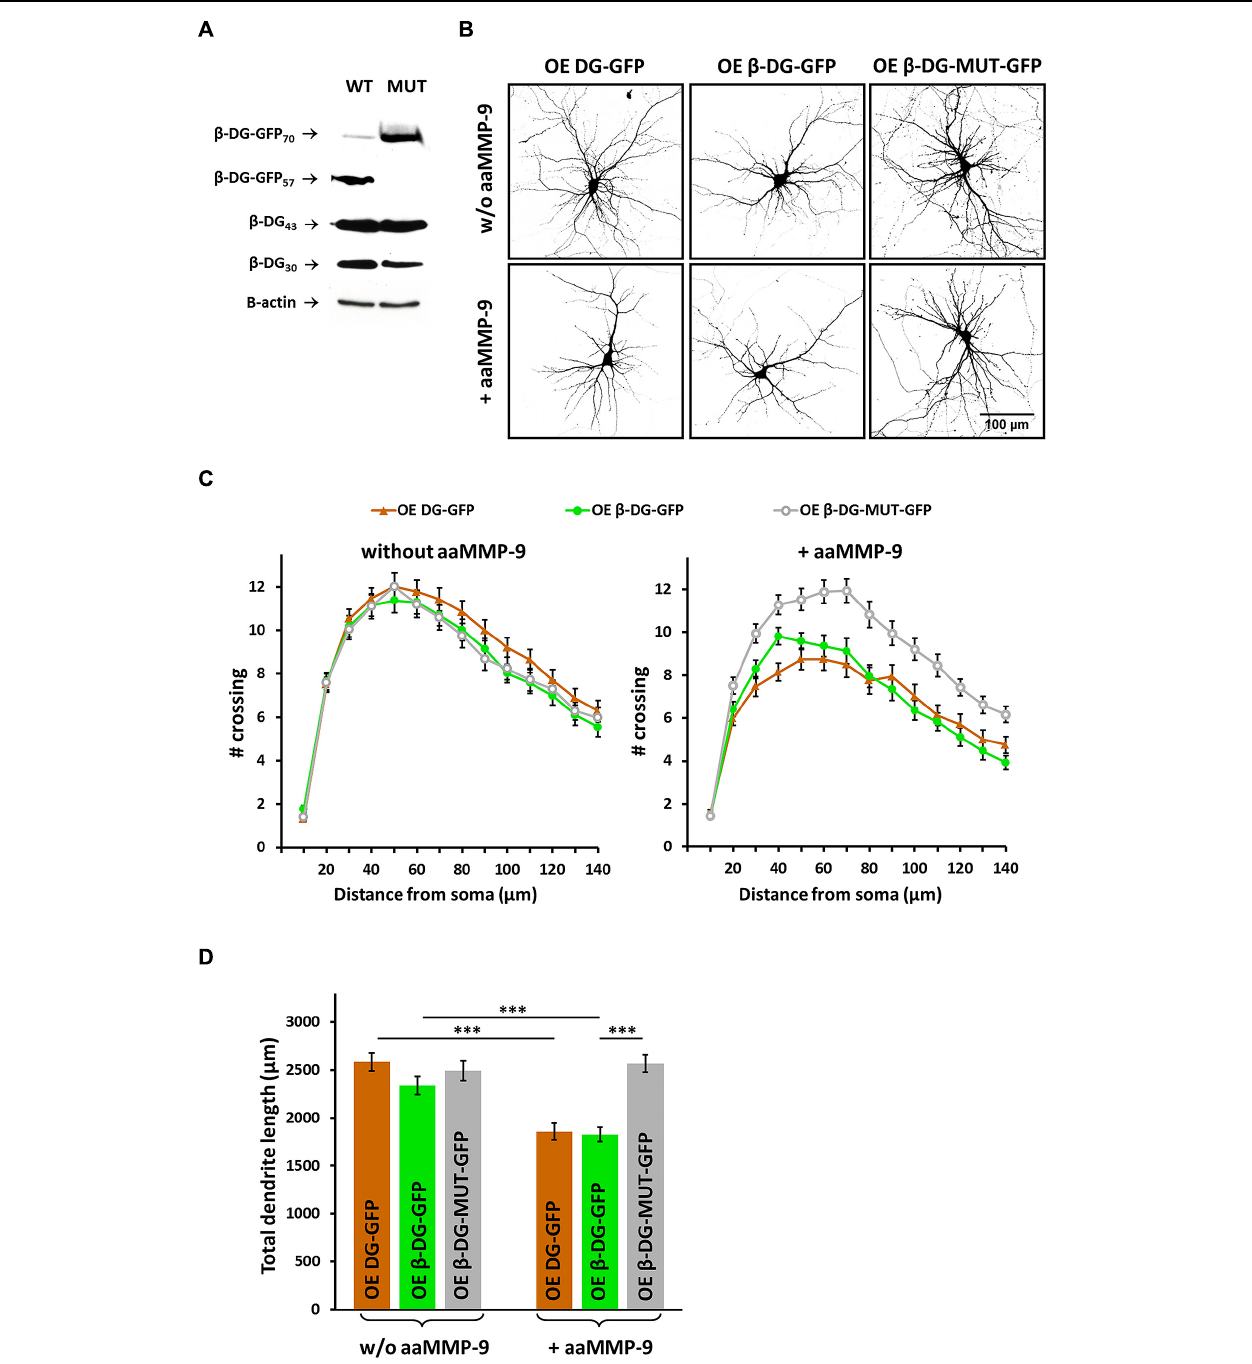
FIGURE 4 | Matrix metalloproteinase-9 dependent cleavage of β -DG is important for dendritic development. (A) Immunoblot analysis of β -DG and GFP expression in protein lysates from HEK 293 cells transfected with either OE β -DG-GFP (WT) or OE β -DG-MUT-GFP (MUT) plasmids and then treated with aaMMP-9. β -actin served as a loading control. (B) Representative images of neurons used for the morphometric analysis. The cells were co-transfected with an RFP-coding vector to visualize the exact morphology. (C) Sholl analysis of hippocampal neurons treated as indicated ( n cell = 50 ± 4). In control cultures (without aaMMP-9), no statistically significant differences were found between